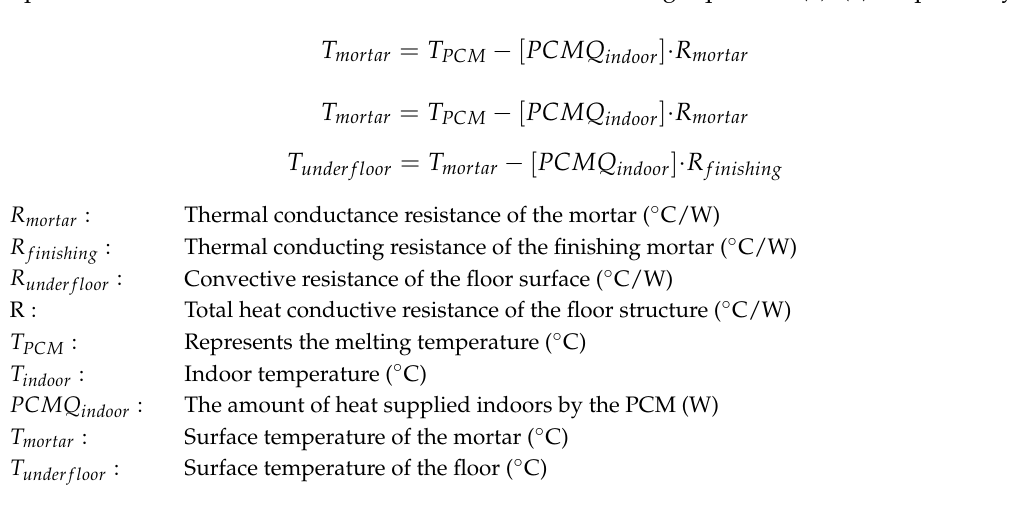
Table 1. Results of the calculation of PCM latent heat emission, mortar temperature, and floor surface